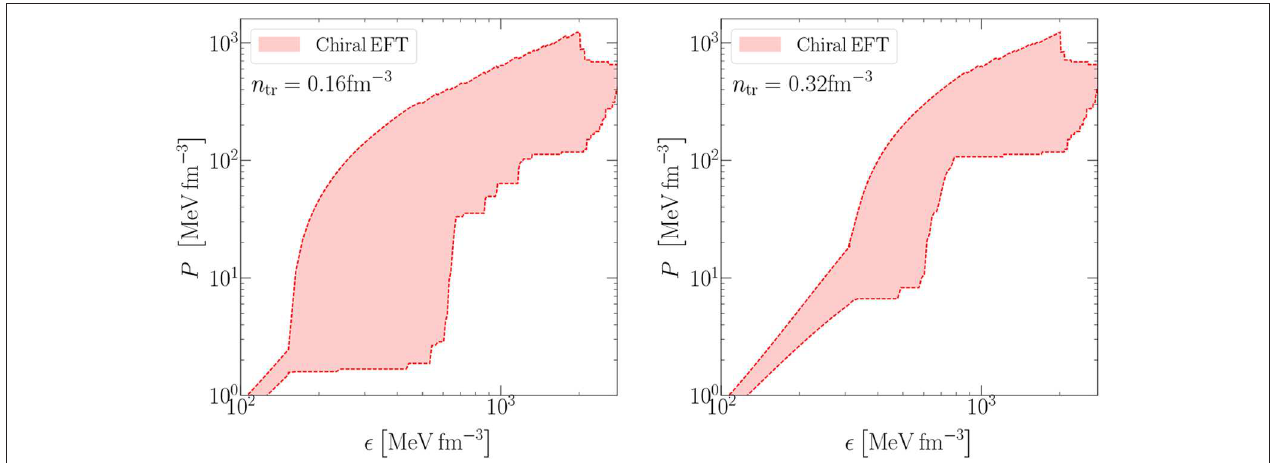
n sat (left) and n tr FIGURE 5 | Equation-of-state envelopes for n tr 2 n sat (right) . Adapted by permission from Springer Nature, Tews et al. [50], copyright 2019. = = I show the resulting EOS envelopes in Figure 5 for n tr = n sat (left panel) and n tr 2 n sat (right panel). These =